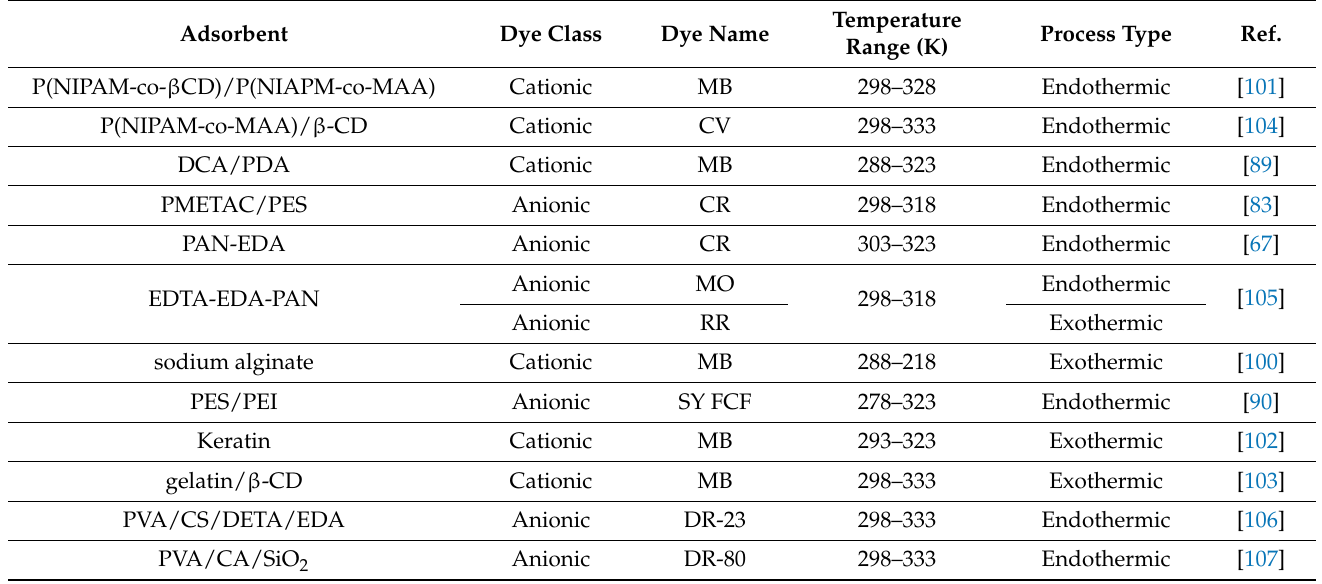
Table 2. Effect on adsorption of different dyes on the surface of electrospun polymer nanofibers (EPNFs). Adsorbent Dye Class Dye Name